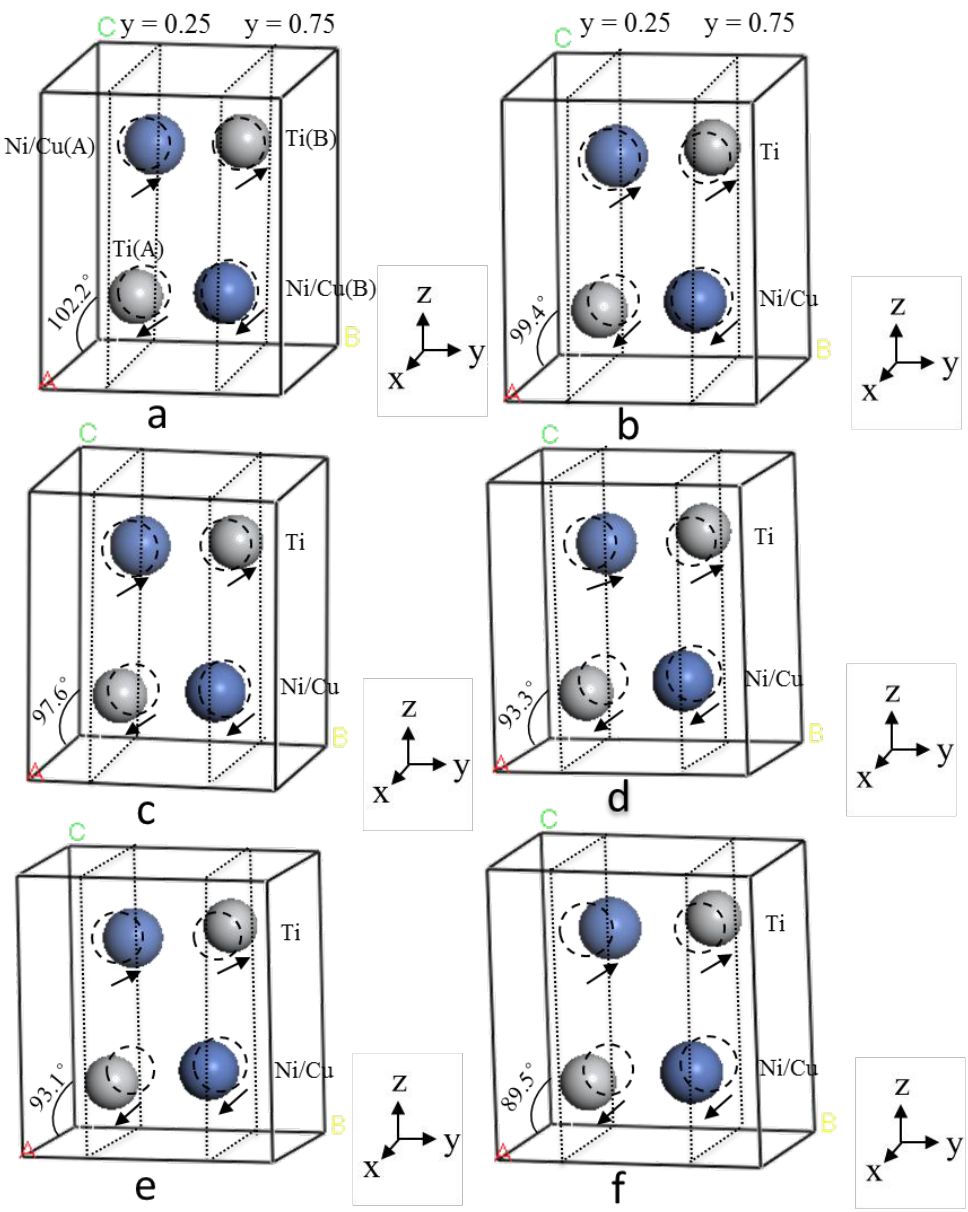
Figure 3. 3D diagrams showing the atomic positions of ( a ) Ti 50 Ni 45 Cu 5 ; ( b ) Ti 50 Ni 37.5 Cu 12.5 ; ( c ) Ti 50 Ni 35 Cu 15 ; ( d ) Ti 50 Ni 31.25 Cu 18.75 ; ( e ) Ti 50 Ni 30 Cu 20 ; and ( f ) Ti 50 Ni 25 Cu 25